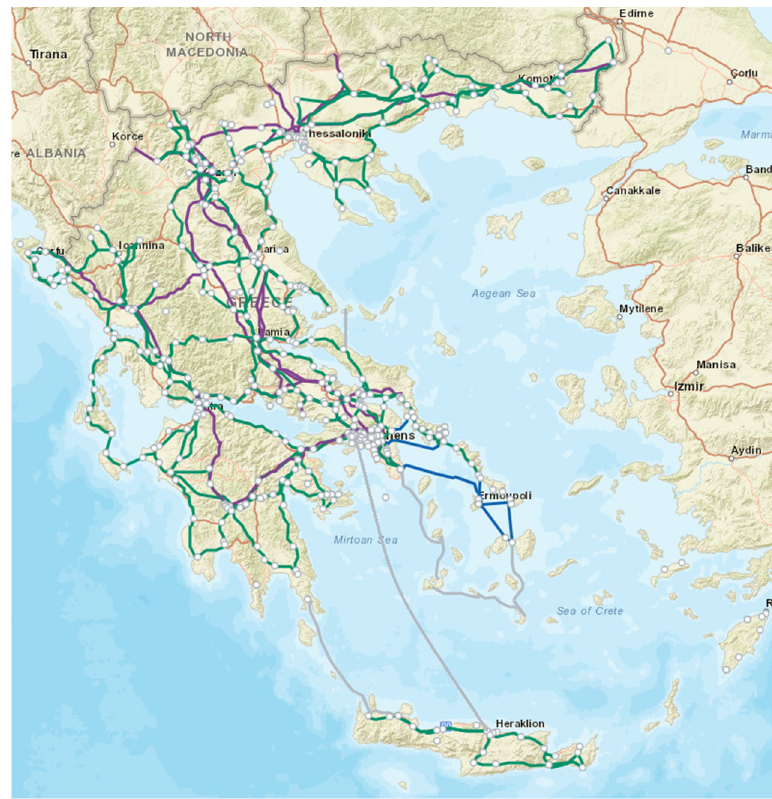
Figure 1. Map of the interconnected Hellenic Transmission System (HETS). Projects in progress are noted (grey lines), e.g., dual interconnection of Crete, a 150 kV/AC double circuit and a bipolar voltage source converter HVDC (VSC-HVDC), and southeastern Cycladic Islands (under planning/permitting licensing).